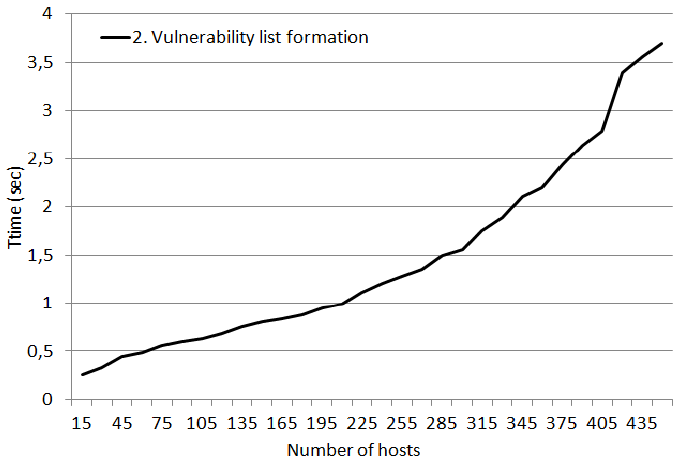
Figure 12. Dependency between the time (sec) required for vulnerability list formation and the amount of hosts in the network (when the ontological repository is